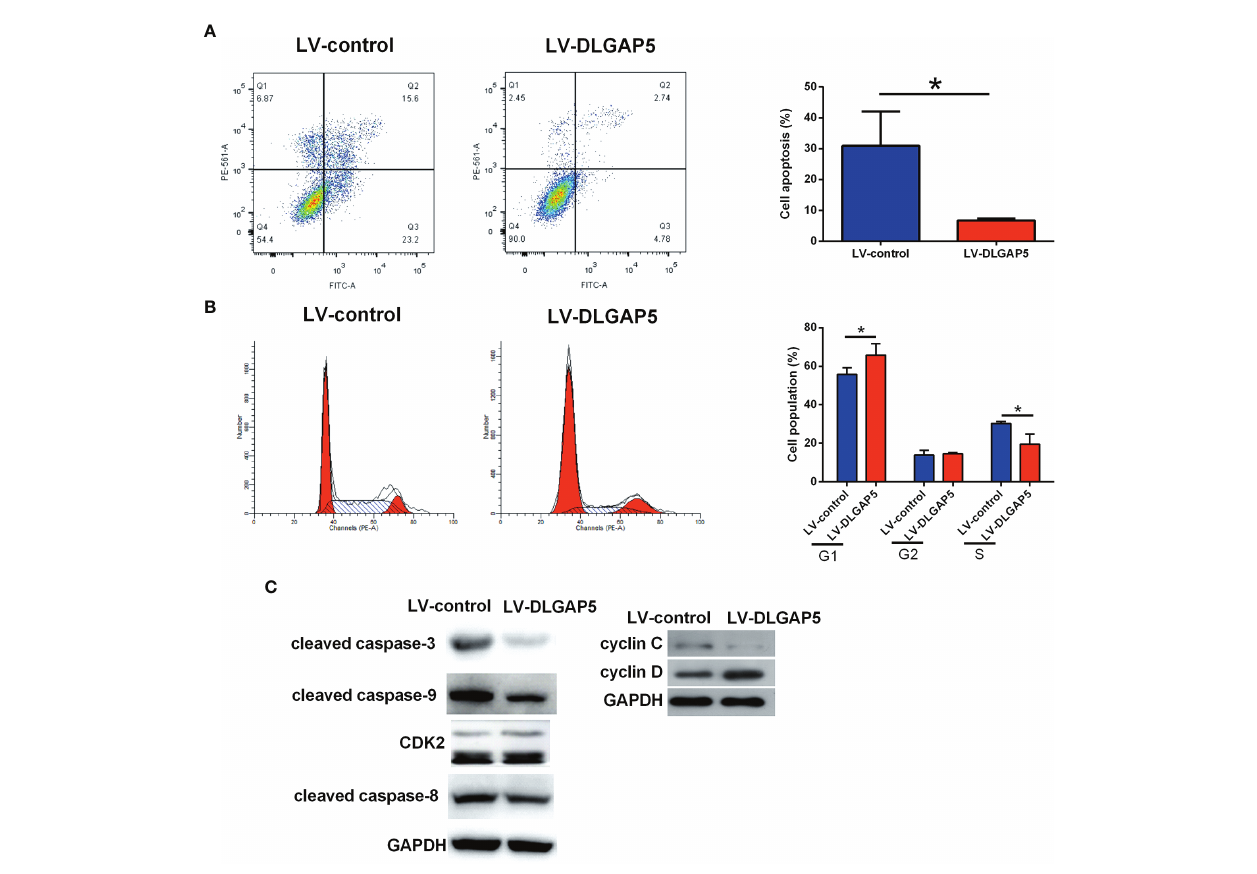
FIGURE 10 | Effects of DLGAP5 overexpression on the granulosa cell apoptosis and cell cycle. Granulosa cells were transfected with LV-control or LV-DLGAP5, and after transfection, (A) the cell apoptotic rates and (B) cell cycle of granulosa cells were determined by fl ow cytometry; (C) the protein levels of cleaved caspase- 3, cleaved caspase-9, CDK2, cleaved caspase-8, cyclin C and cyclin D in granulosa cells were determined by Western blot assay. *P <